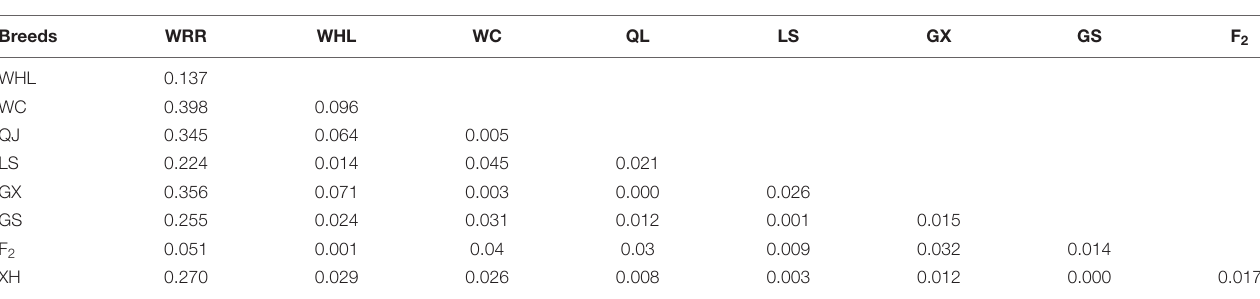
TABLE 2 | Pairwise fixation index (Fst) of RIN2 in chicken breeds. Breeds